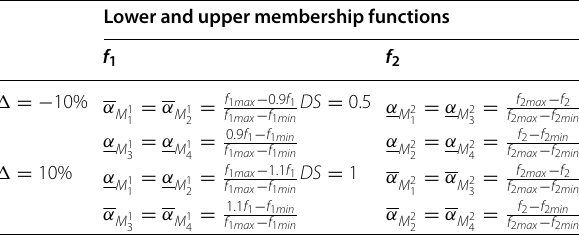
Table 1 Type-2 fuzzy membership functions Lower and upper membership